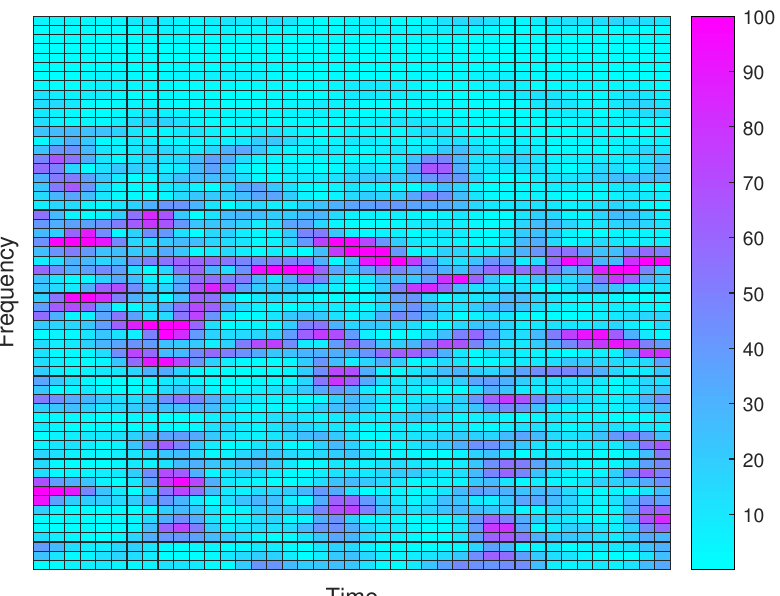
Figure 2. A portion of a recording displayed as a spectrogram. Note that energy values greater than 100 are limited to